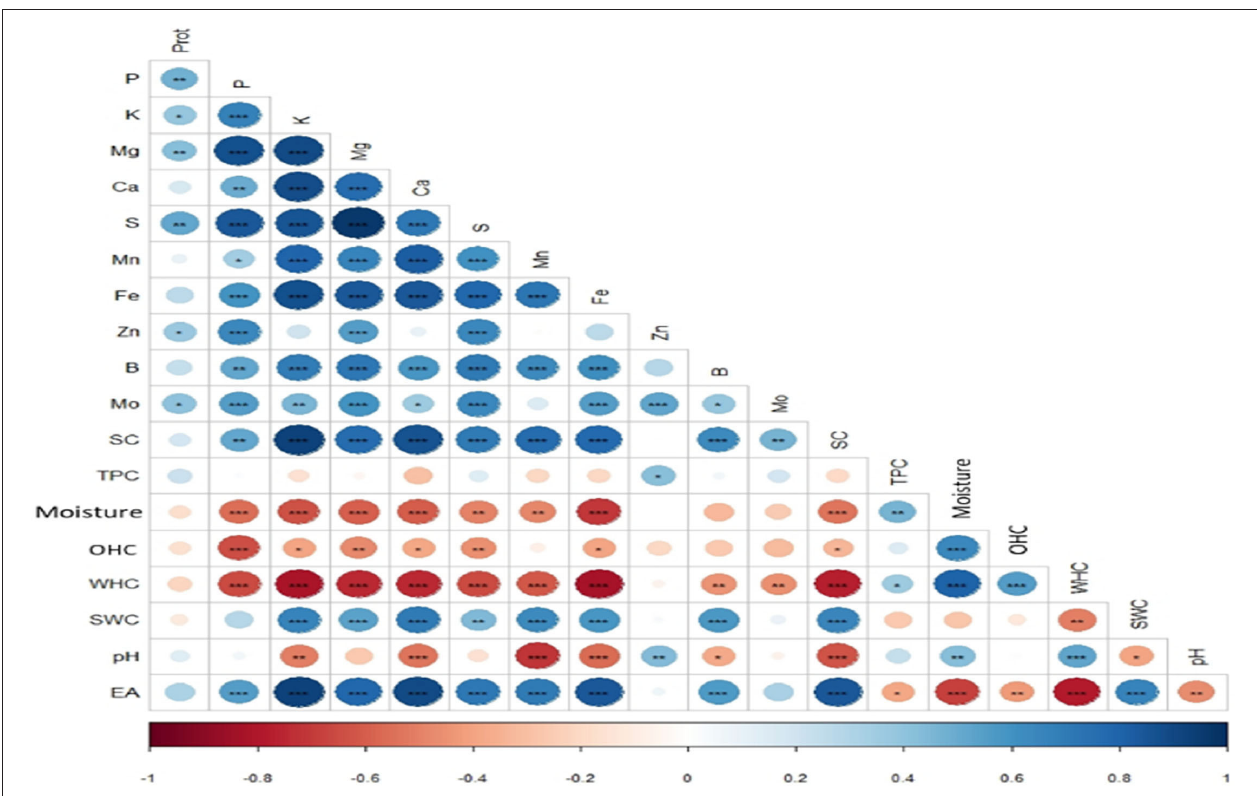
FIGURE 5 | Pearson correlation between different properties during the wet process.